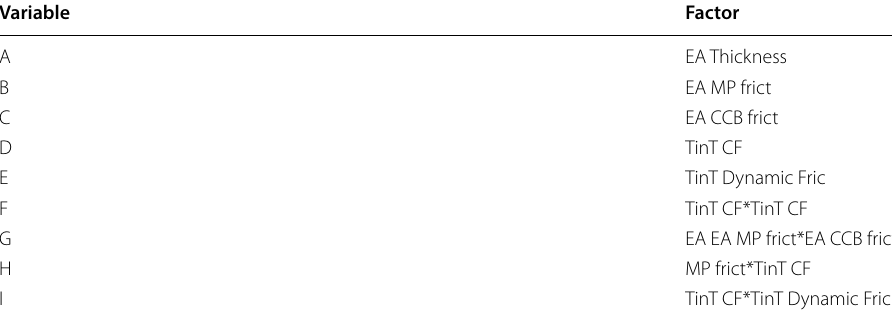
Table 5 Regression equation for 19.5 mm